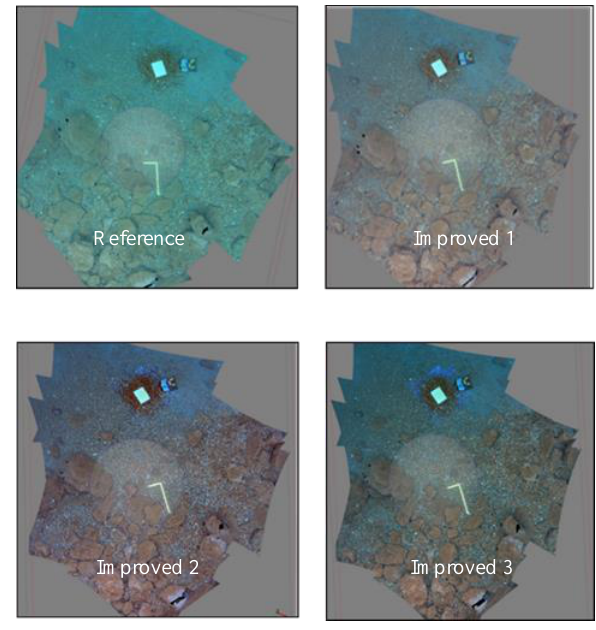
Figure 8. Visual Evaluation 3.3.2 Geometric Evaluation: Objects of known dimensions (scales bars) have been used for the estimation of the geometric quality, while there were no GCPs for use. Two objects have been used as scale bars, a carpenter’s square (70cm × 30cm) and a white slate (23cm × 31cm) (Table 4). The scale bars are visible in the four models of Figure 8.